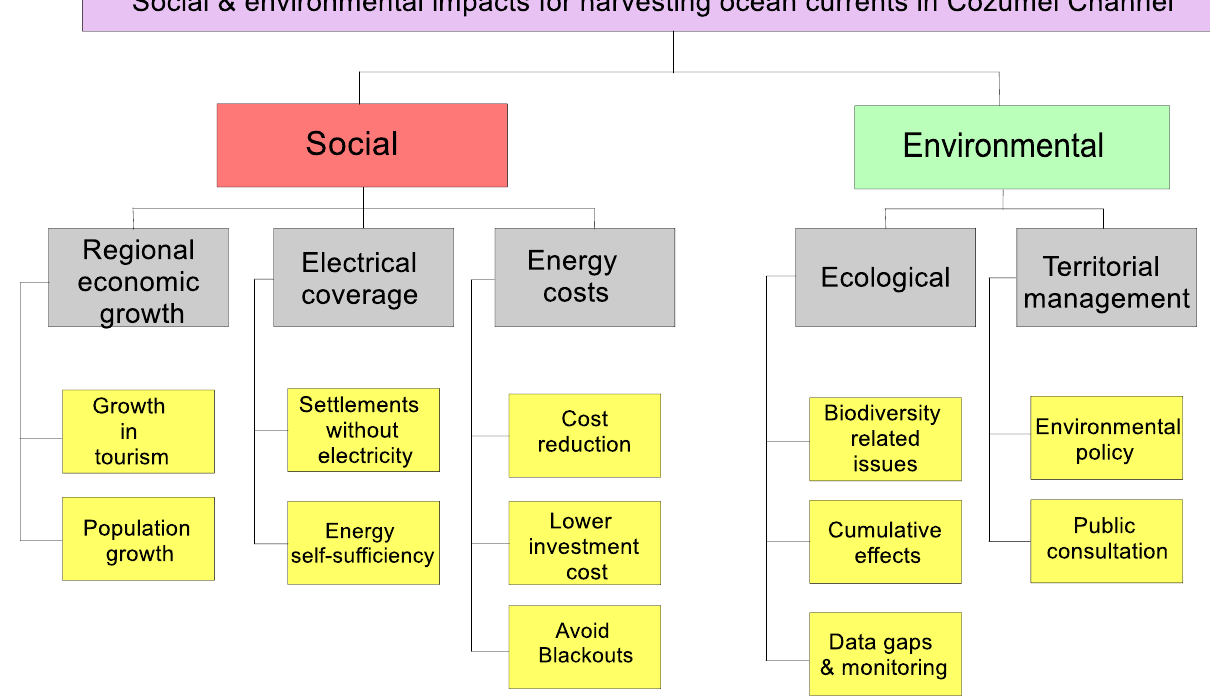
Figure 9. Social and environmental impacts from using the ocean currents in the Cozumel Channel to generate electricity through hydrokinetic devices.